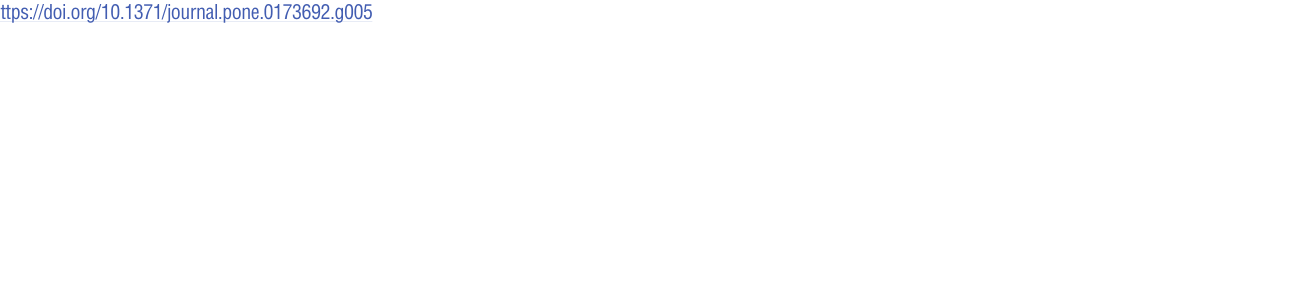
PLOS ONE | https://doi.org/10.1371/journal.pone.0173692 March 16,